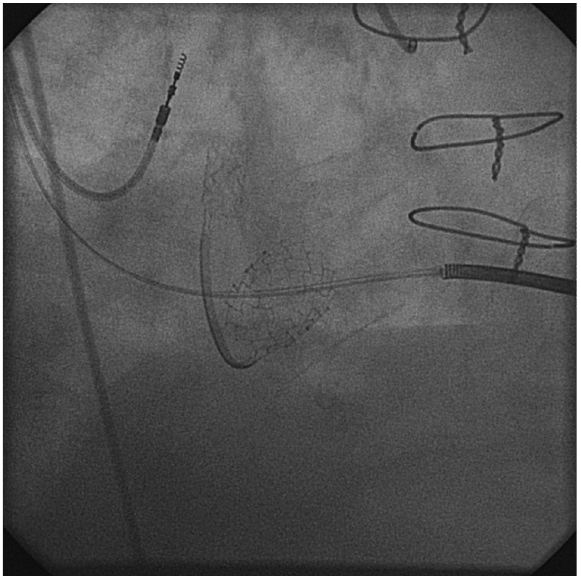
Figure 1 . MONARC device implantation in 2009.